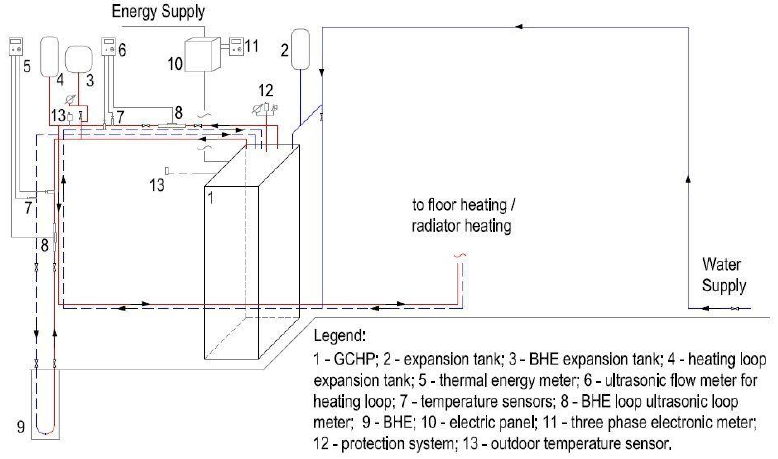
Figure 5. Experimental ground-coupled heat pump (GCHP) system.